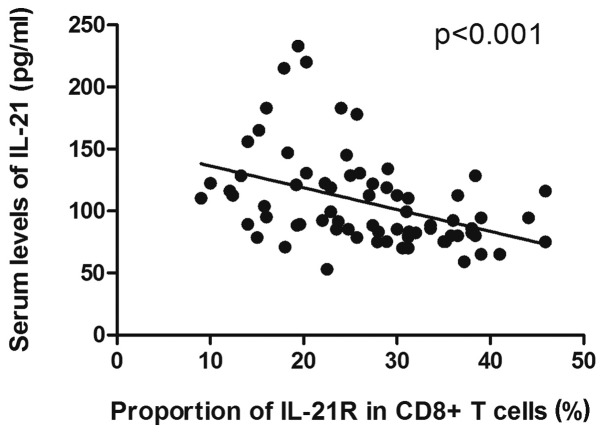
Analysis of the correlation between serum levels of IL-21 and IL-21R expression on peripheral CD8+ T cells in the patients with DLBCL. Each symbol represents a subject. The P-value is shown. IL-21, interleukin 21; IL-21R, IL-21 receptor; CD8, cluster of differentiation 8; DLBCL, diffuse large B-cell lymphoma.